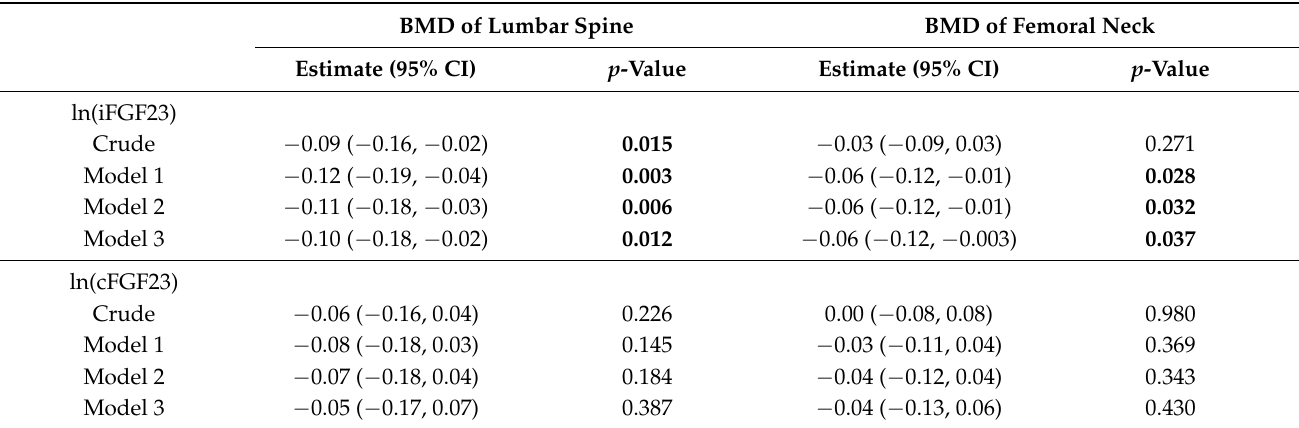
Table 3. Linear regression analysis of the association between iFGF23 and cFGF23 and bone mineral density in patients on chronic